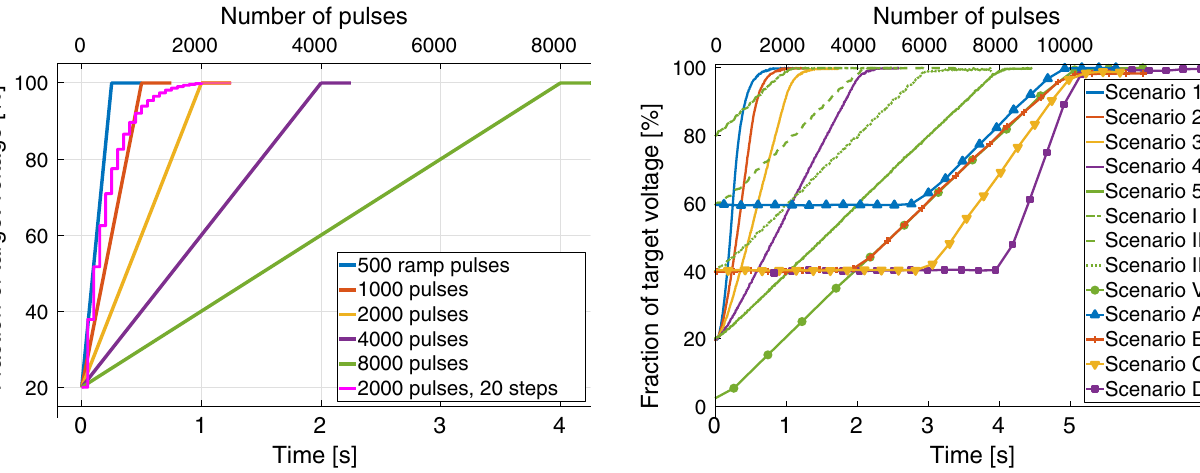
FIG. 2. Actual measured voltage increase in each of the ramping scenario as a function of time and the number of